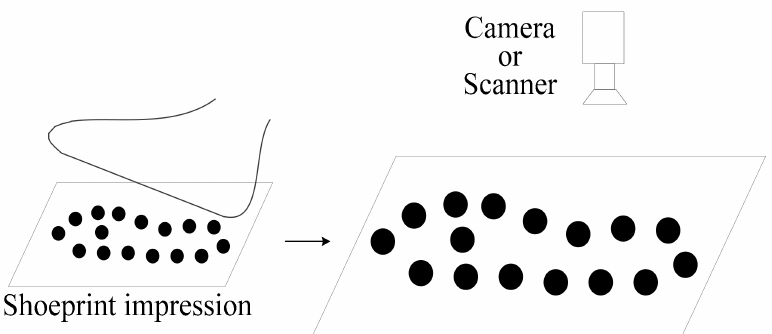
Figure 4. The imaging process of the reference shoeprints.